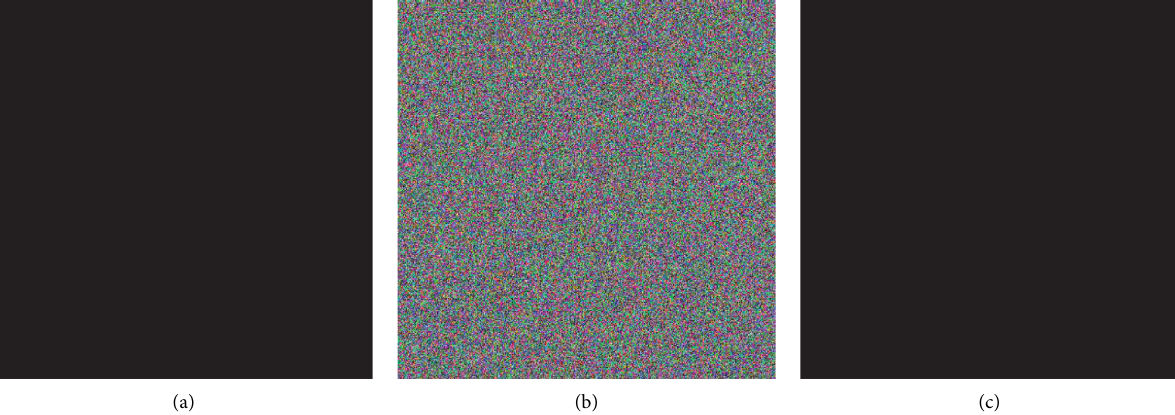
Figure 4: Plaintext image P , the corresponding ciphertext image C 2 image P . (b) The corresponding ciphertext image C 2